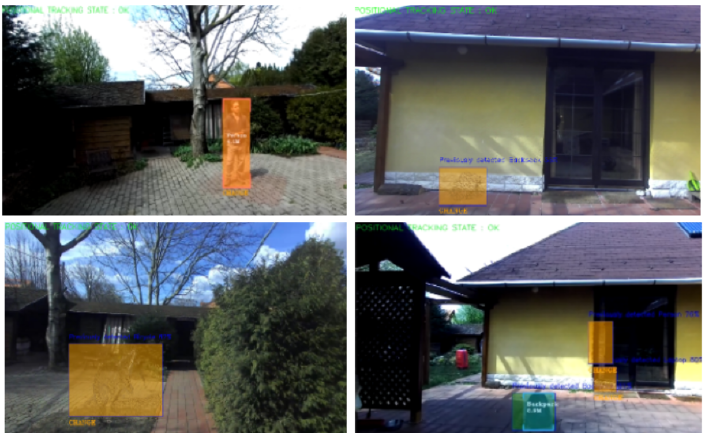
Figure 7. Examples of changes due to removed or added objects (shown in orange overlay). For changes caused by removed objects, the point clouds of previous detections are overlaid on the 2D image (top right, bottom left and bottom right